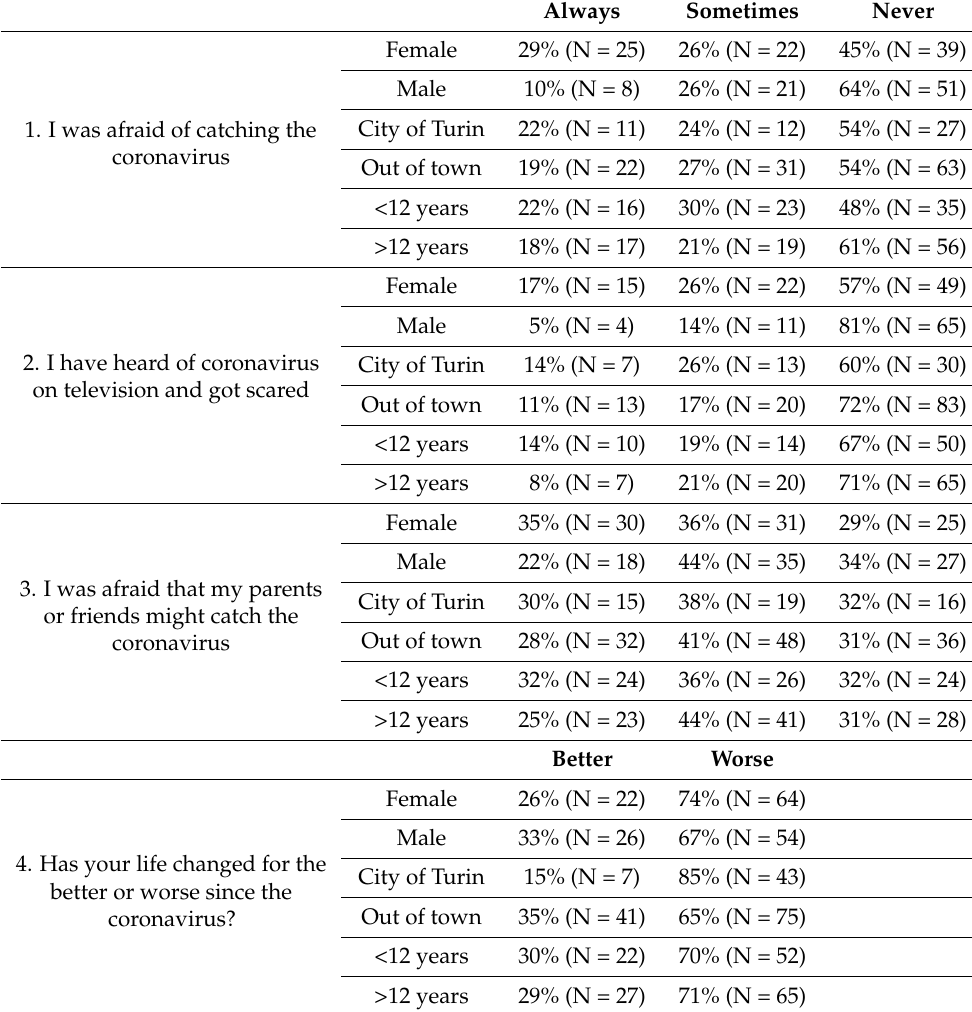
Table 2. Emotional experience and feelings towards the pandemic considering gender, residence and age of the whole